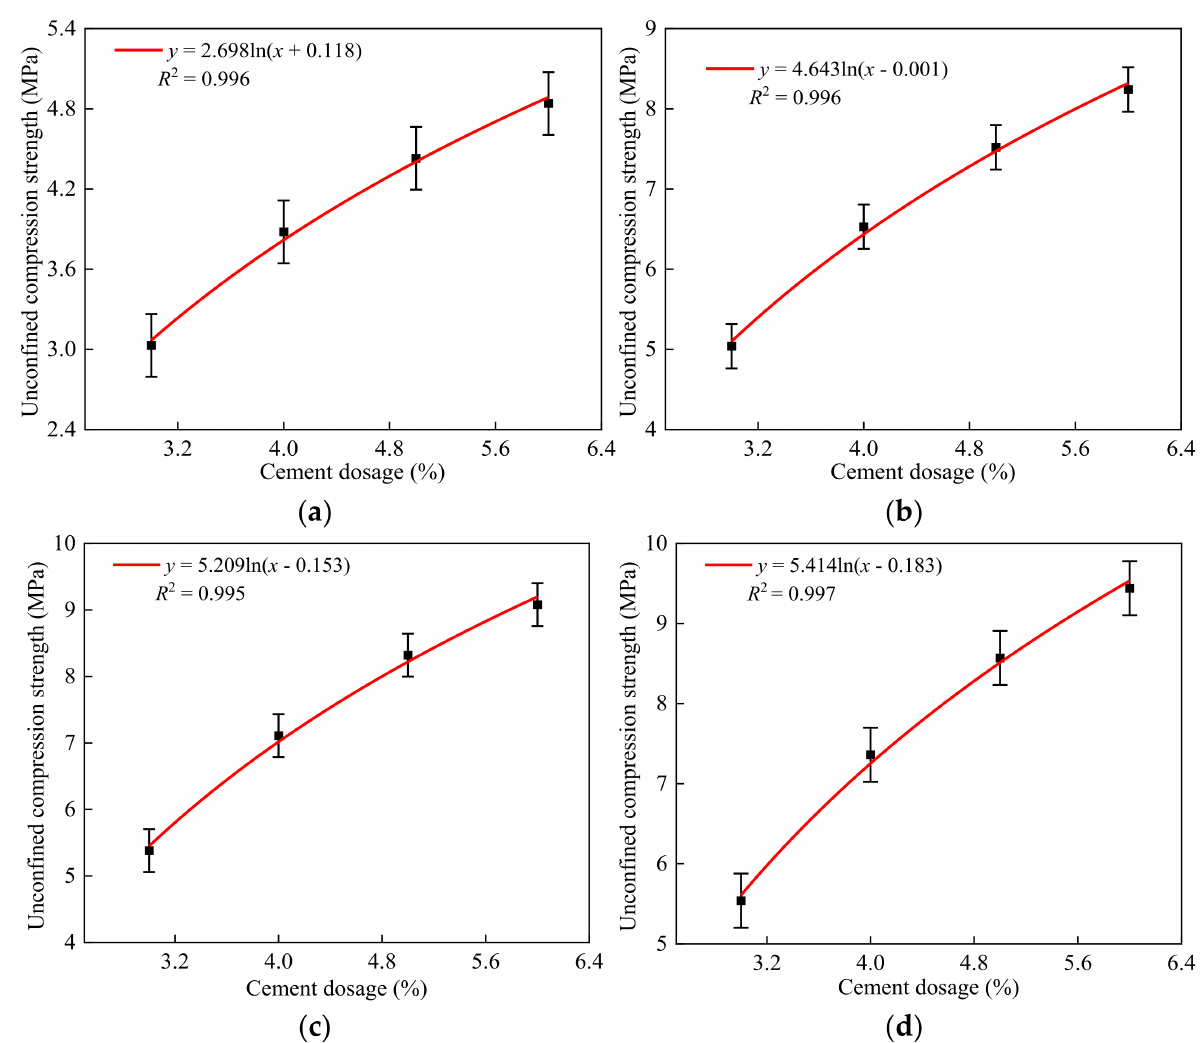
Figure 6. The fitting formulas of the unconfined compressive strengths for different cement content with different curing ages: ( a ) 7 days, ( b ) 28 days, ( c ) 56 days, and ( d ) 90